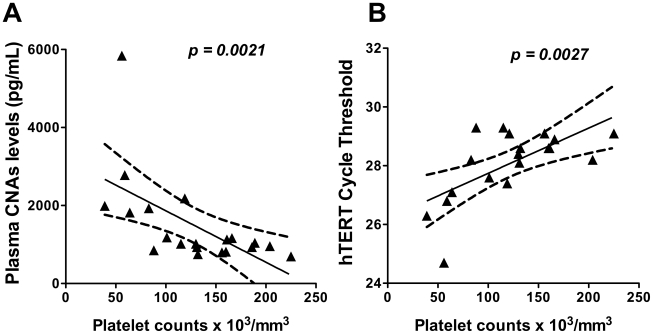
Correlation between plasma CNAs levels and malaria vivax thrombocytopenia.Correlation of plasma CNAs levels with platelet counts in symptomatic vivax malaria patients. The dsDNA levels measured by Pico Green (A) and the mean cycle threshold for hTERT amplification (B) were plotted against the platelet counts. Spearman (r = −0.6451) and Person (r = 0.6479) correlations were used respectively in A and B. A p value<0.05 was considered significant.